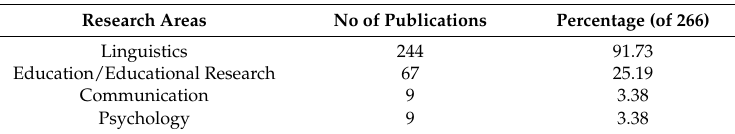
Table 3. Research areas for SLW publications with the number of publications and their percentages in